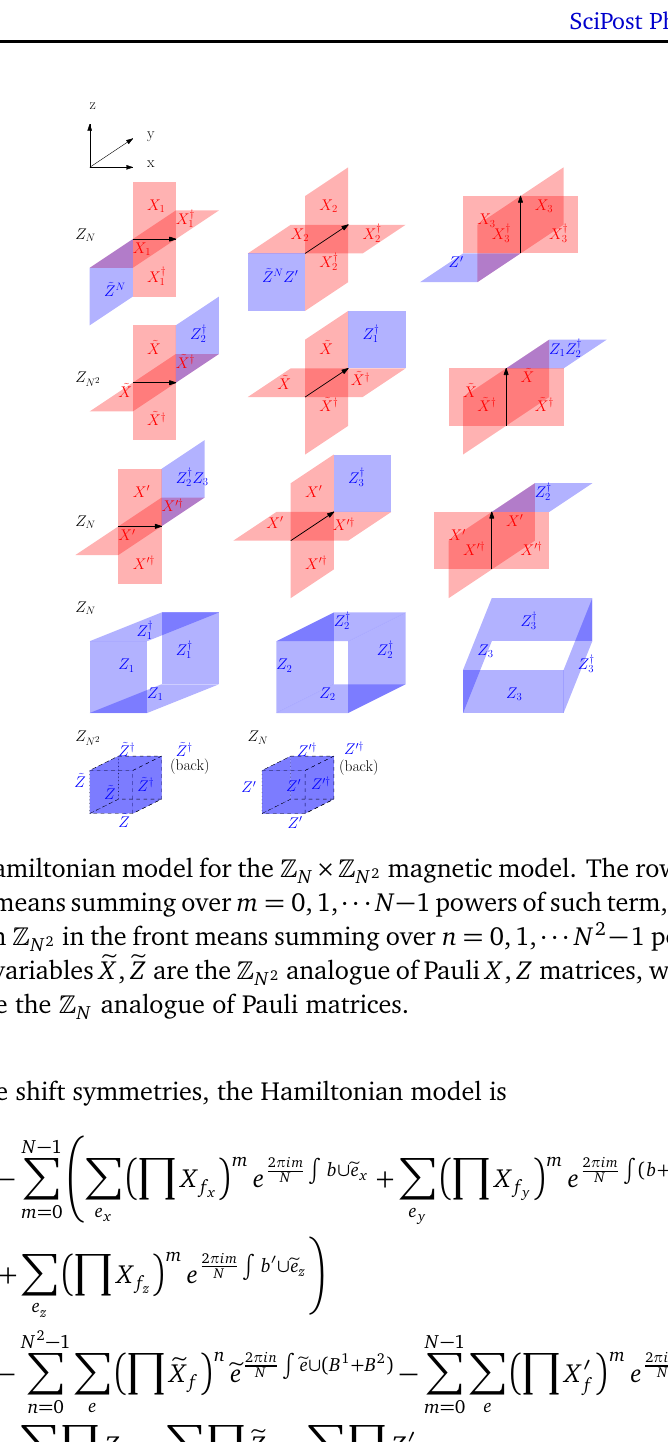
degrees of freedom associated with B i , B j , b (cid:48) and (cid:90) degrees N N 2 , L , L along the three directions x y z